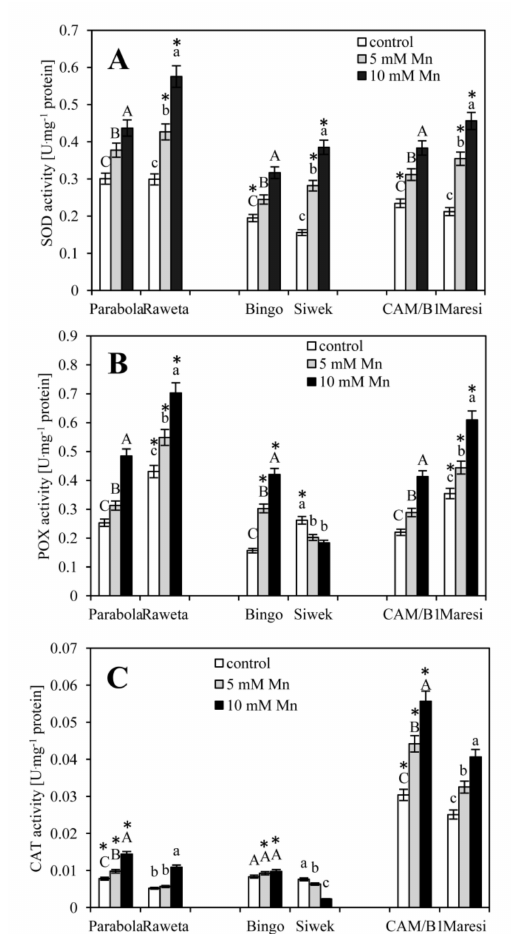
Figure 2. Activity of superoxide dismutases (SODs) ( A ), peroxidases (POX) ( B ), and catalase (CAT) ( C ) [U / mg protein] in wheat (Parabola-tolerant and Raweta-sensitive), oats (Bingo-tolerant and Siwek-sensitive) and barley (CAM / B1-tolerant and Maresi-sensitive) cultivars, grown in water (control) and at 5 and 10 mM MnCl 2 . Values are mean of five replications ( ± SE). Di ff erent letters indicate significant ( p < 0.05) di ff erences between treatments. Di ff erences between cultivars are marked as “*”.